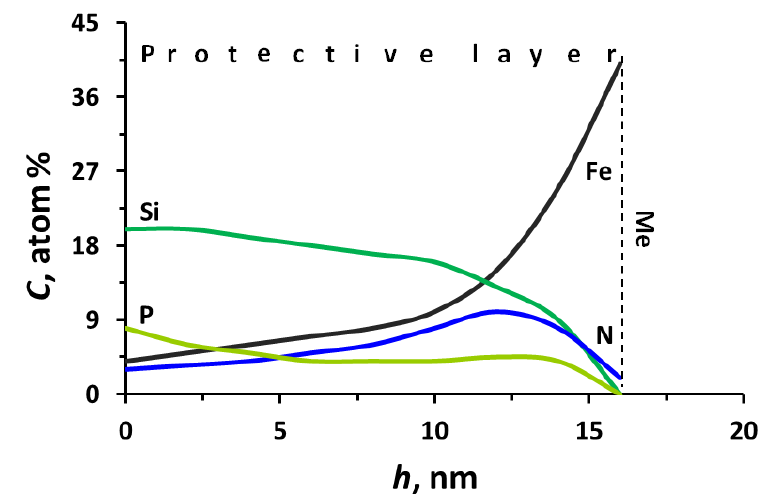
Figure 9. Distribution of the concentration ( C ) of chemical elements over the depth ( h ) of the protective layer after 60 min of exposure of the samples in ID and ultrasonic cleaning.